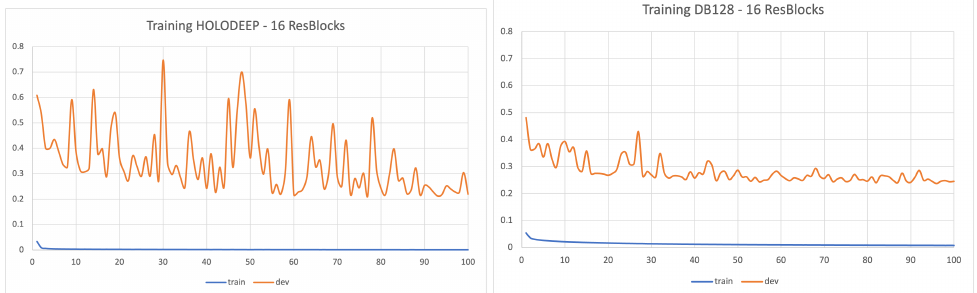
Figure 2. Evolution of the loss function (RMSE) at each epoch when training on HOLODEEP ( left ) or DB128 ( right ). Mean obtained on the training dataset (blue) and the development set, here are the complete images from HOLODEEP (orange). Table 2. ∆ φ (rad) obtained by DnCNN models with 4 or 16 ConvBlocks trained on HOLODEEP, or DB128. The averaged ∆ φ (rad) is given on our three test databases (in average). Training